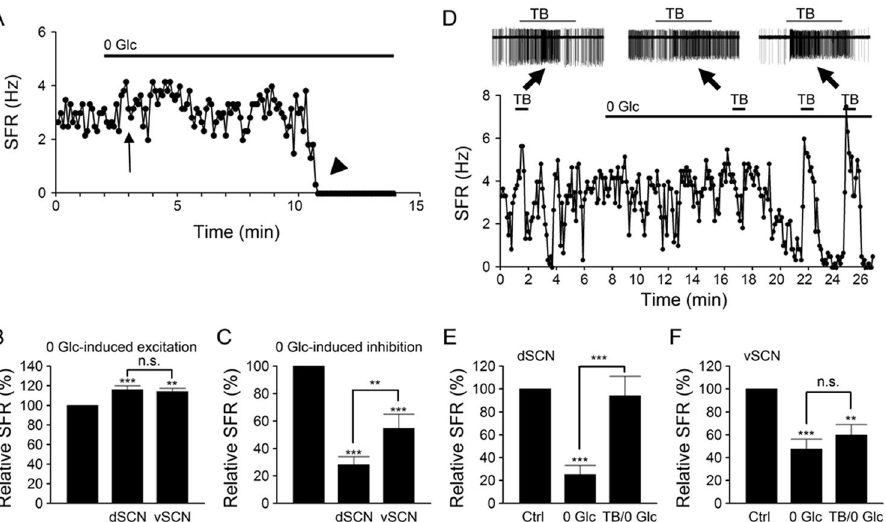
Figure 6. Glucoprivation produces biphasic effect on spontaneous firing. ( A ) A representative dSCN neurone showing the biphasic effects, early excitation (marked by arrow) and delayed inhibition (marked by arrowhead), of glucose-free (0 Glc) solution on spontaneous firing rate (SFR). Daytime recordings (ZT 8). ( B ) Statistics showing that glucoprivation provoked similar early excitation in dSCN and vSCN neurones. ( C ) Statistics showing that glucoprivation produced a larger steady-state inhibition in dSCN than vSCN neurones. Baseline spontaneous firing rate: dSCN (3.4 ± 0.4 Hz; n = 18), vSCN (3.5 ± 0.3 Hz; n = 12). ( D ) A representative dSCN neurone showing that tolbutamide-sensitive K ATP channels mediate glucoprivation-induced inhibition of spontaneous firing. Insets show the original traces. Note the marked excitatory effect of tolbutamide (TB) (right inset) when glucose-free solution began to inhibit spontaneous firing. Nighttime recordings (ZT 16). ( E , F ) Statistics showing the relative spontaneous firing rate in control (Ctrl), steady-state inhibition by glucose- free solution (0 Glc), and the effect of tolbutamide (TB/0 Glc) in dSCN ( E ) and vSCN ( F ) neurones. Baseline spontaneous firing rate: dSCN (3.0 ± 0.3 Hz; n = 12), vSCN (3.2 ± 0.4 Hz; n = 9). ** P < 0.01, *** P <